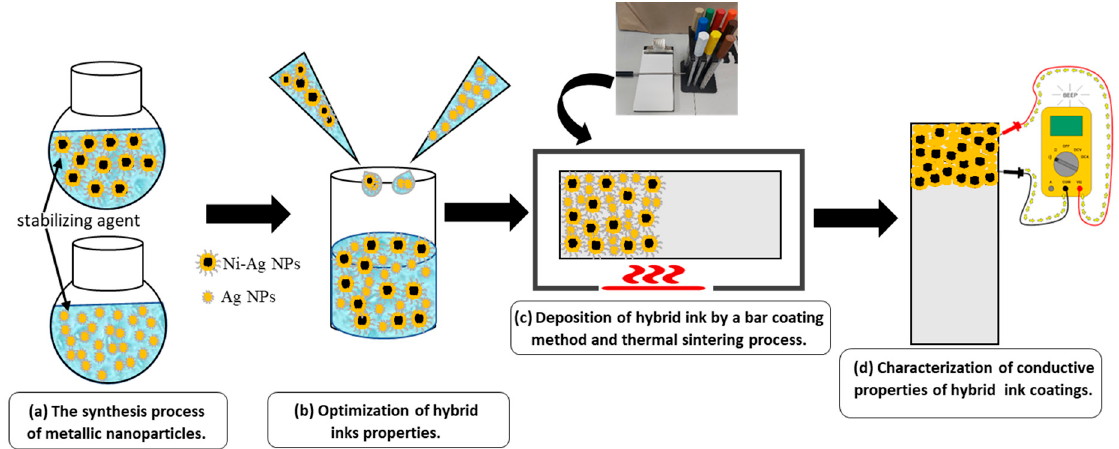
Figure 1. Scheme of the preparation of conductive coatings based on Ni-Ag nanoparticles (NPs): ( a ) optimization of the process of synthesis of metallic NPs (Ni-Ag and Ag); ( b ) preparation and optimization of properties of nanocomposite ink (based on Ni-Ag and Ag NPs); ( c ) deposition process of nanocomposite inks and sintering of obtained coatings; ( d ) characterization of conductive properties of nanocomposite ink coatings.